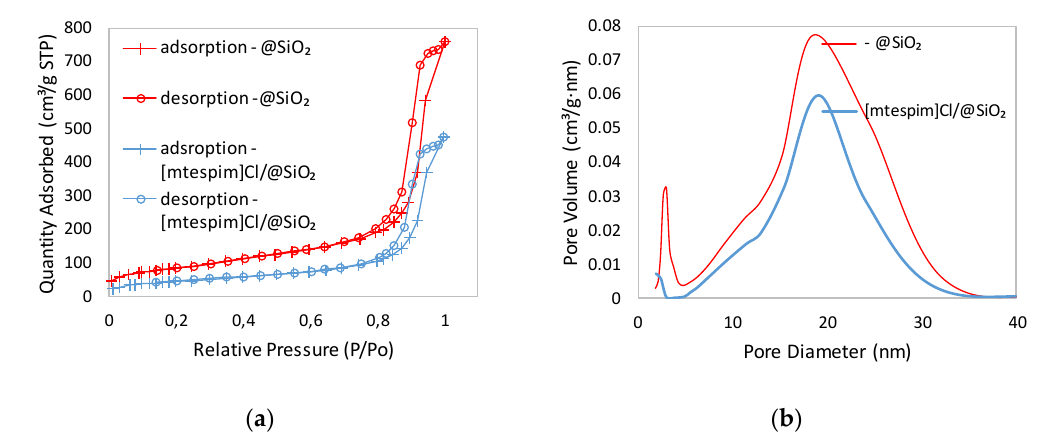
Figure 1. ( a ) Nitrogen adsorption–desorption isotherms; and ( b ) Size distribution plots of synthesized silica @SiO 2 and the catalyst immobilized on the @SiO 2 ([mtespim]Cl/@SiO 2 ) (see also in ESI, Figures